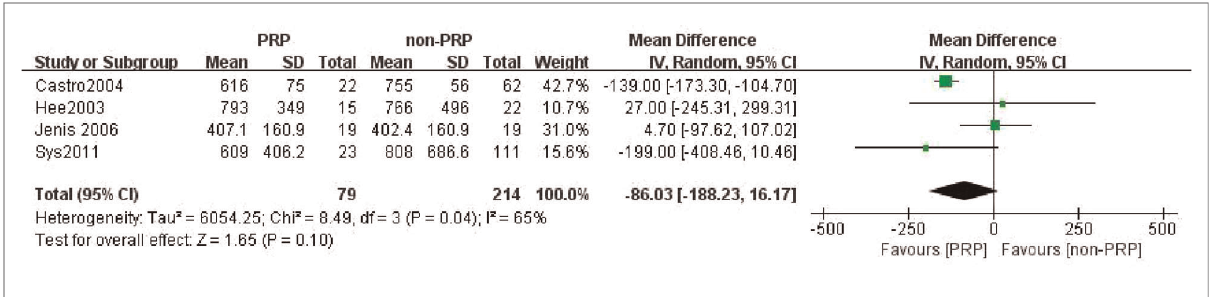
FIGURE 6 Forest plot of the EBL (excluding the amount of blood consumed for PRP preparation).